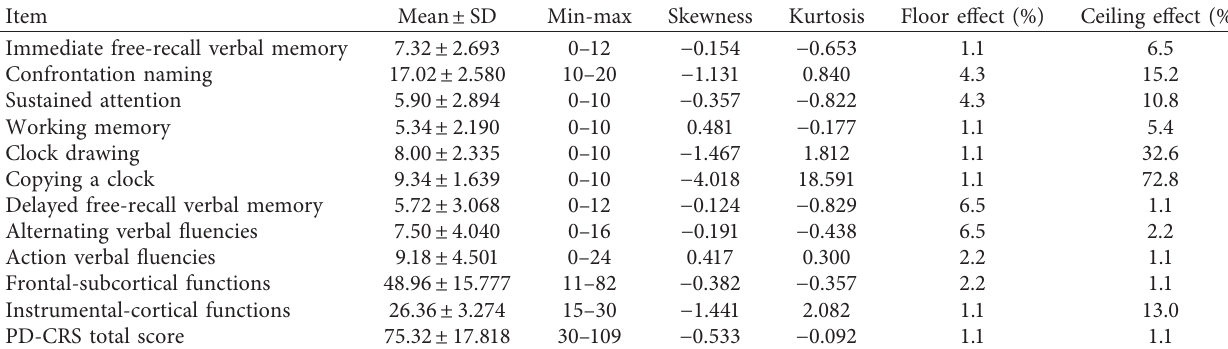
Table 3: Acceptability of PD-CRS.